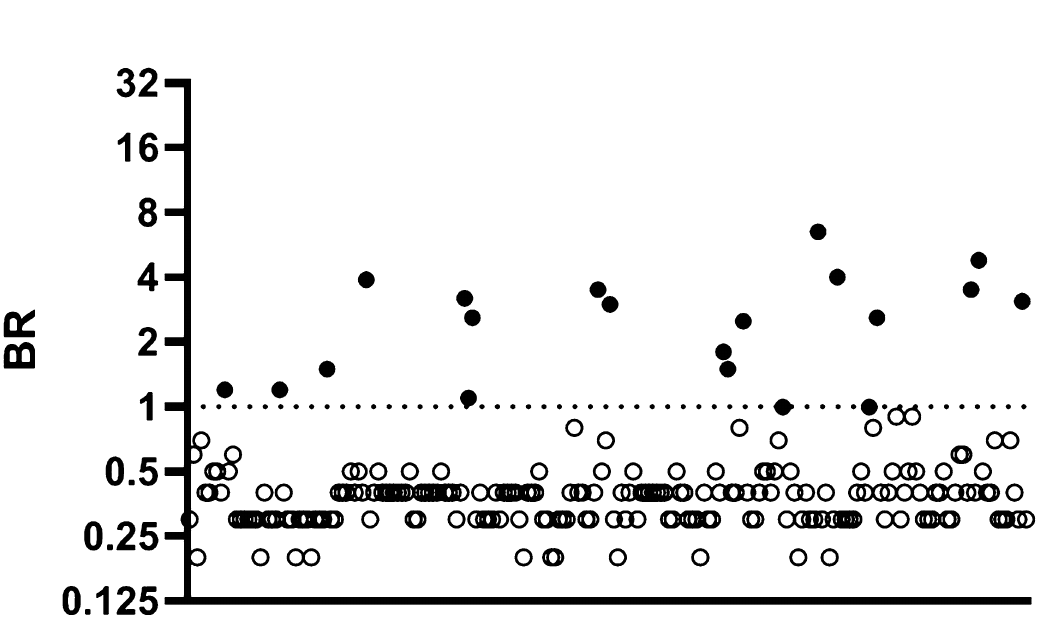
Figure 6. Seroprevalence determined by self-sampling and DBS analysis. DBS samples were obtained via self- sampling from 215 individuals employed in a London-based law firm. The BRs for S1 IgG alone are plotted on a log 2 scale. Samples from 20 sero-positive individuals are shown with filled circles and those from sero-negative individuals with empty circles. The dotted line indicates the assay